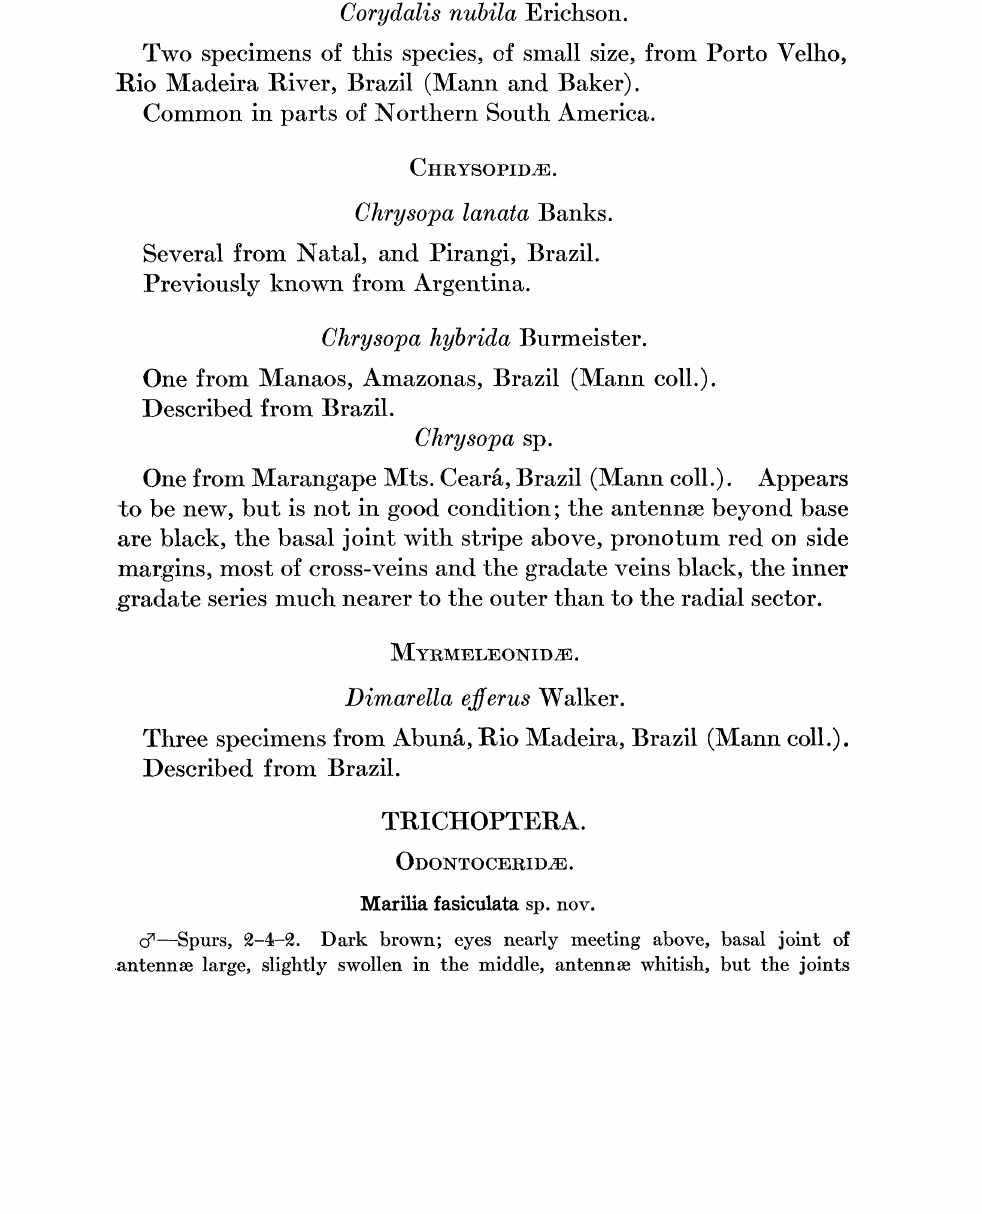
ing. In hind wings also two branches of radial sector, and four cubital cross-veins; in both wings two cross-veins beyond end of the subcosta. Expanse 19